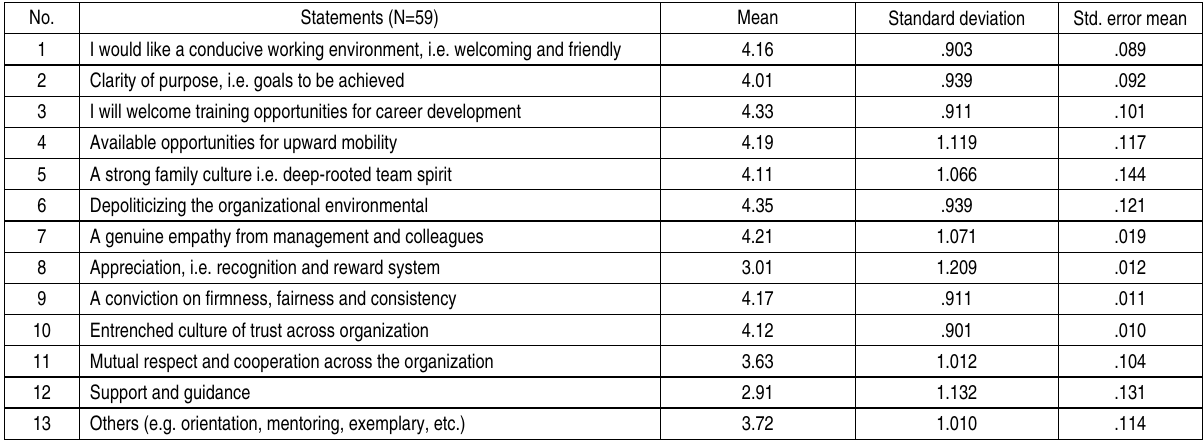
Table 6. Means and standard deviations of critical training elements to promote organizational commitment